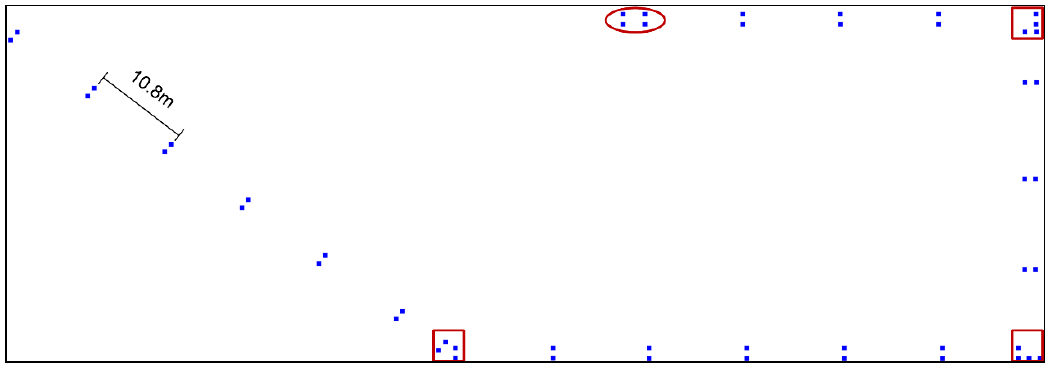
Figure 3. The distribution of selected sparse RPs with the interval of 10.8 m, where the red square rectangle denotes the start and end of adjacent structures, the red ellipse refers to the partition less than the interval.